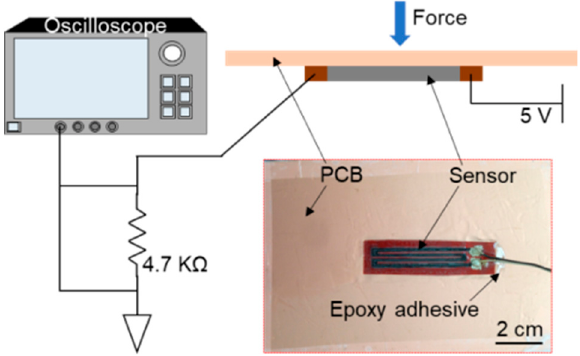
Figure 8. Schematic illustration of the experimental set-up and prototyped sensor device.